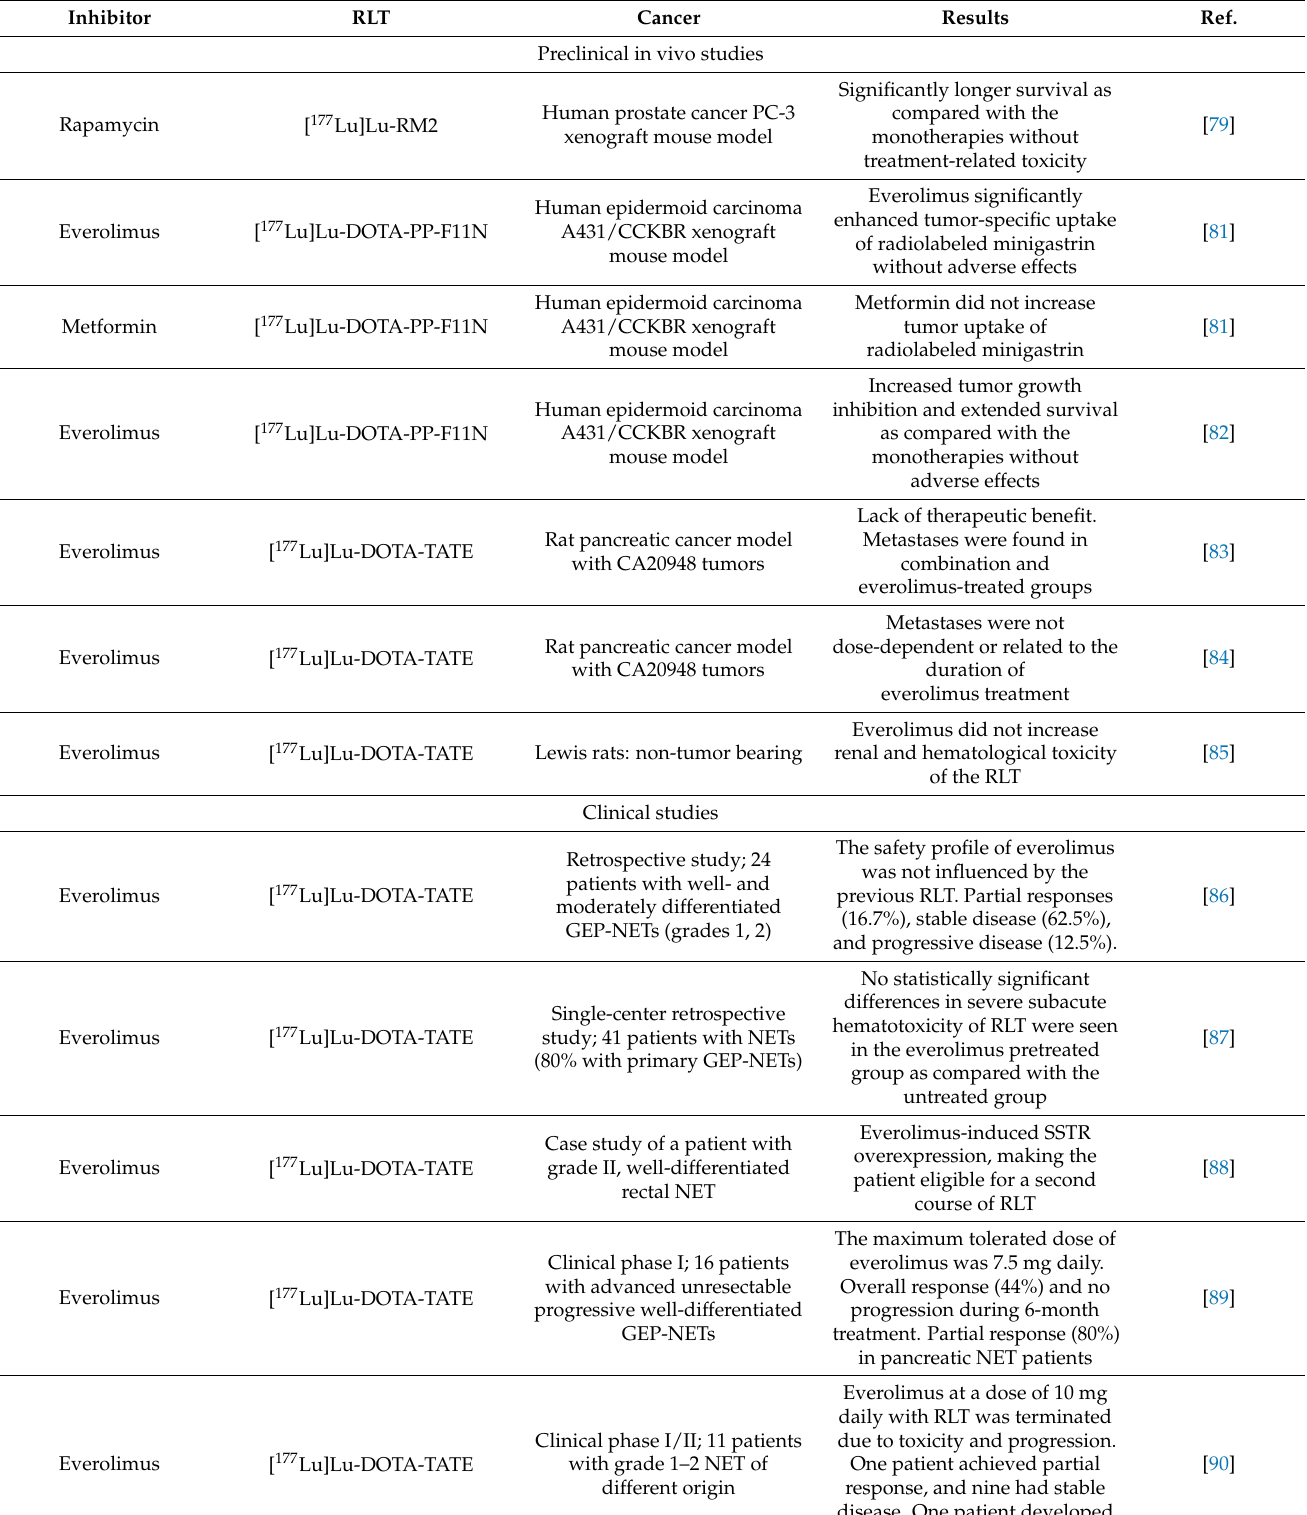
Table 1. Combination of RLTs and mTORC1 inhibitors in animal and clinical